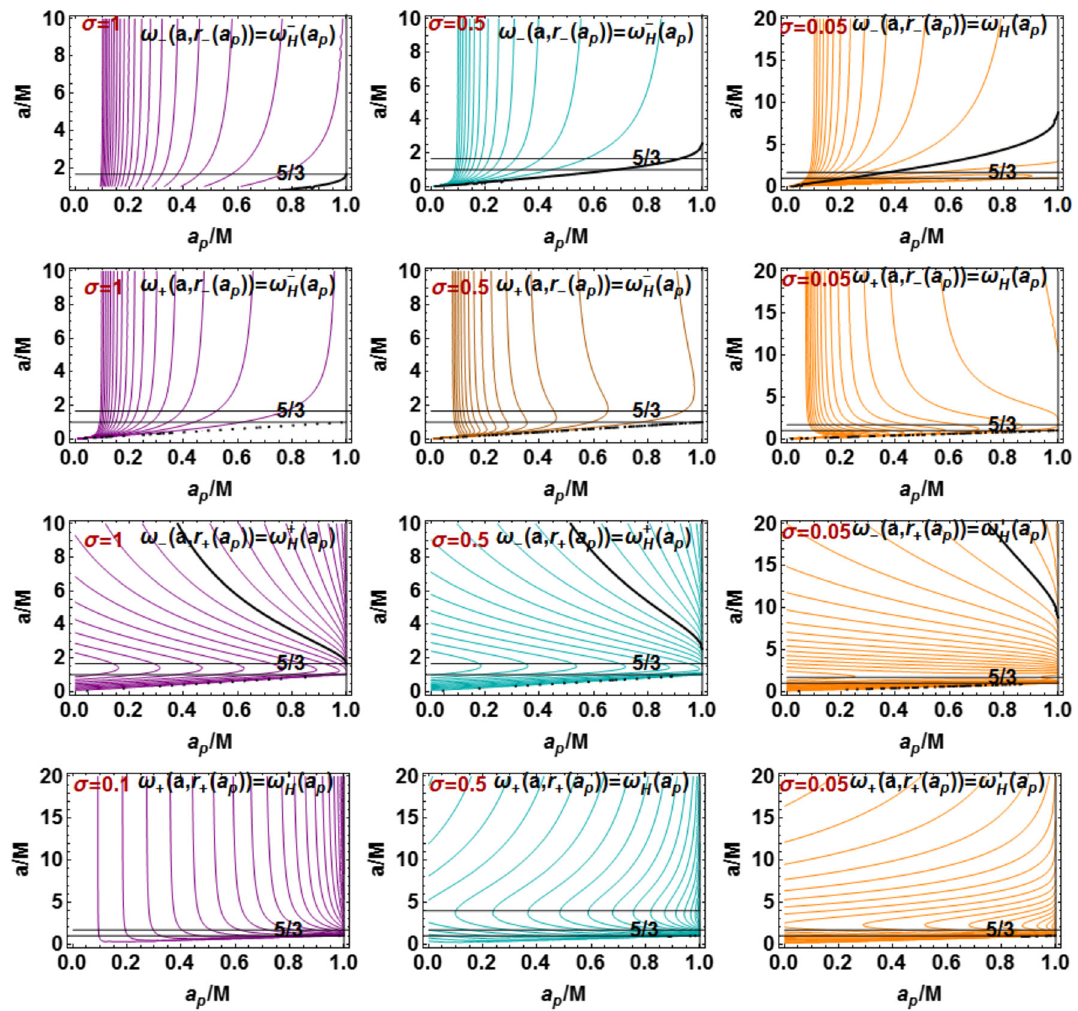
( a ) for (cid:27) = ± 1, where σ ∈ { 0 . 05 , 0 . 5 , 1 } on the plane ( a p H ( a ) – see Eqs (142) p H